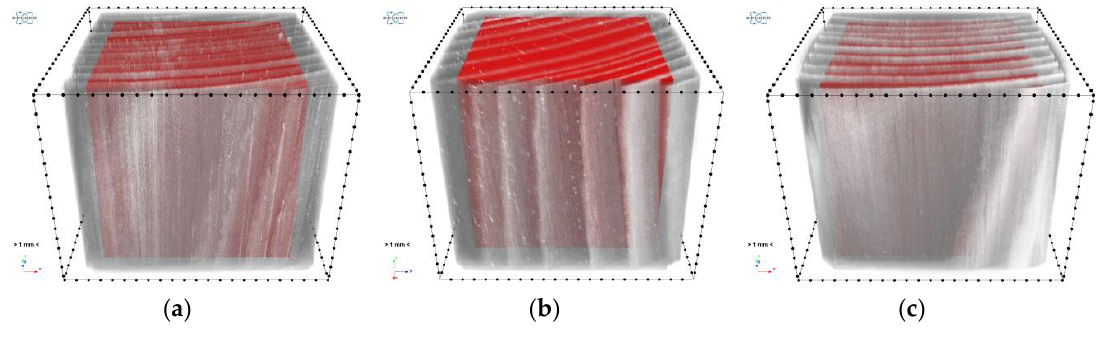
Figure 16. Selection of VOI: ( a ) sample “1” ; ( b ) sample “2” ; ( c ) sample “3”.